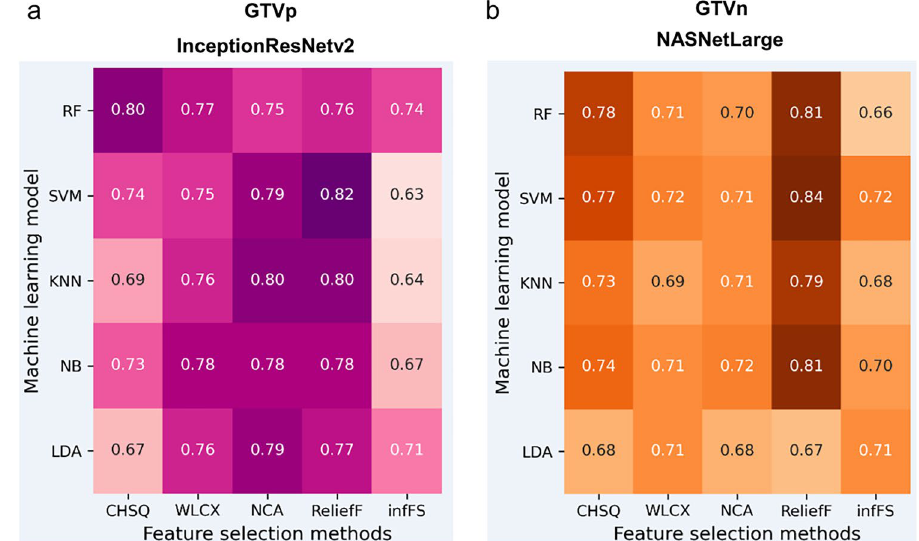
Figure 4. Optimal predictive performance of InceptionResNetv2- and NASNetLarge-based models for predicting GTVp and GTVn regression, respectively. ( a ) Heatmap of the AUCs yielded by 25 InceptionResNetv2-based models (all combinations of five machine learning algorithms in rows and five feature selection algorithms in columns) predicting GTVp regression. ( b ) Corresponding heatmap of AUCs for the 25 NASNetLarge-based models predicting GTVn regression.